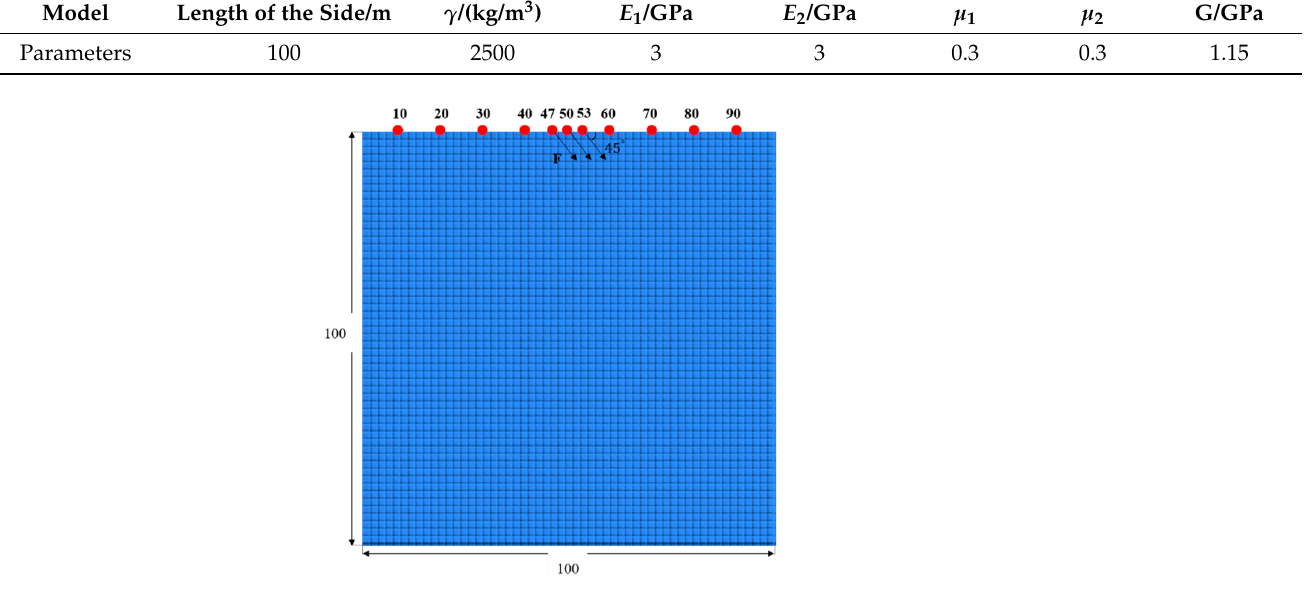
Figure 7. Numerical model.